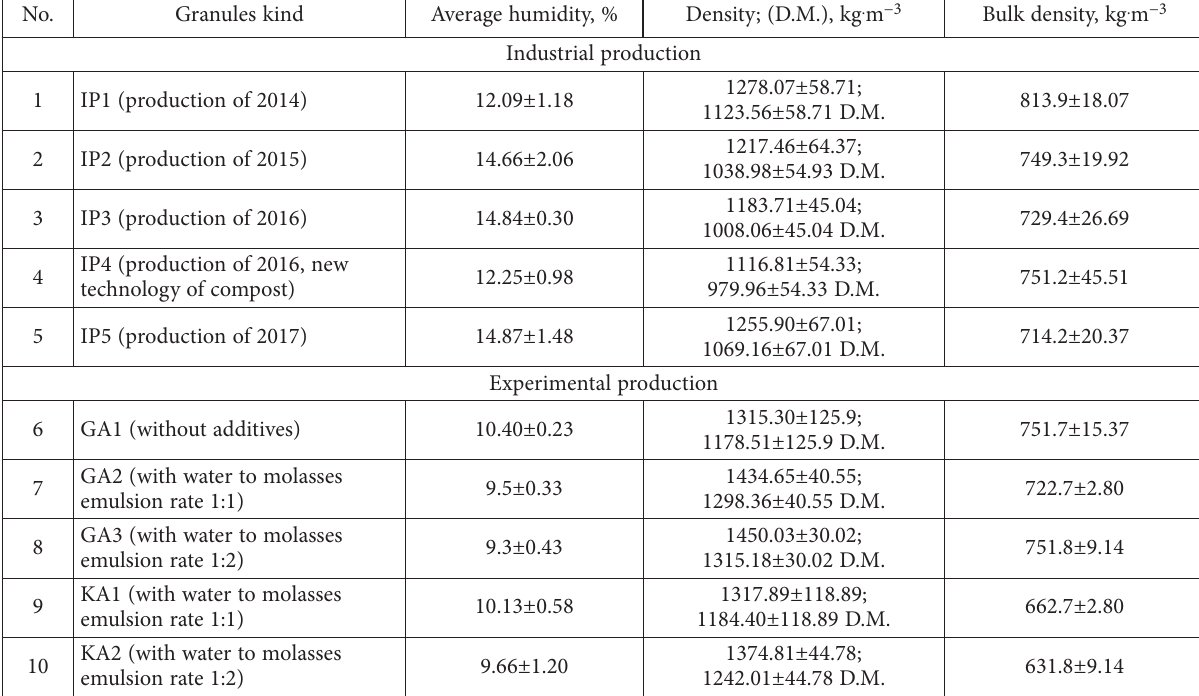
Table 1. The humidity, density and bulk density of organic fertilizer granules